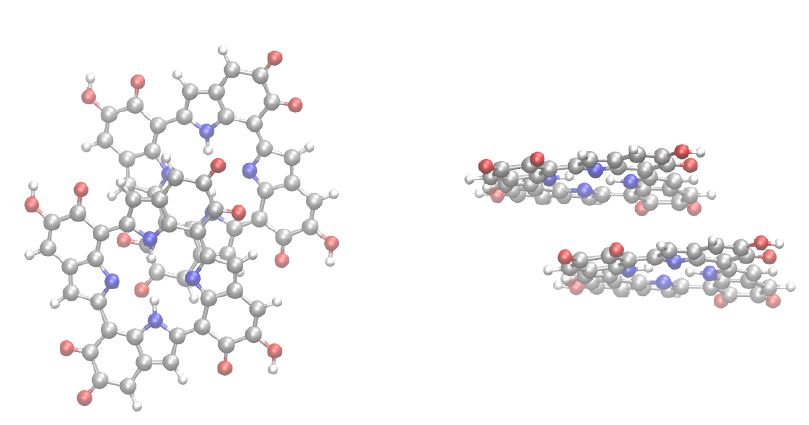
Figure 5. Structure of the IMIM2 dimer. Left: top view; right (side